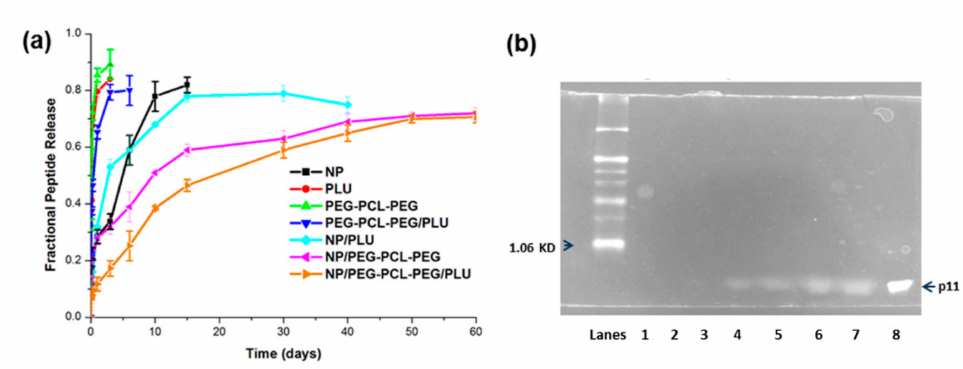
Figure 7. ( a ) Plot depicting the in vitro p11 peptide release from PLGA nanoparticles, Pluronic hydrogel, PLU/PEG-PCL-PEG hydrogel, PEG-PCL-PEG hydrogel, nanoparticle-loaded PEG-PCL-PEG hydrogel and nanoparticle-loaded PEG-PCL-PEG/PLU hydrogel at 37 ◦ C, in PBS for a period of 60 days. ( b ) SDS–PAGE results of p11 peptide in vitro release profile (Lane 1, marker; Lane 2, 5days; Lane 3, 10 days; Lane 4, 20 days; Lane 5, 35 days; Lane 6, 45 days; Lane 7, 55 days; Lane 8 control p11